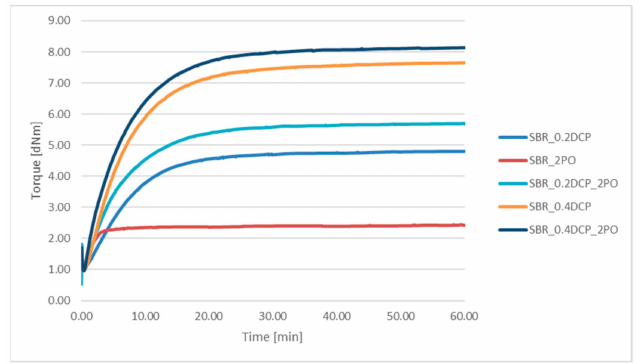
Figure 2. Crosslinking kinetics of the compounds based on styrene-butadiene rubber (SBR).